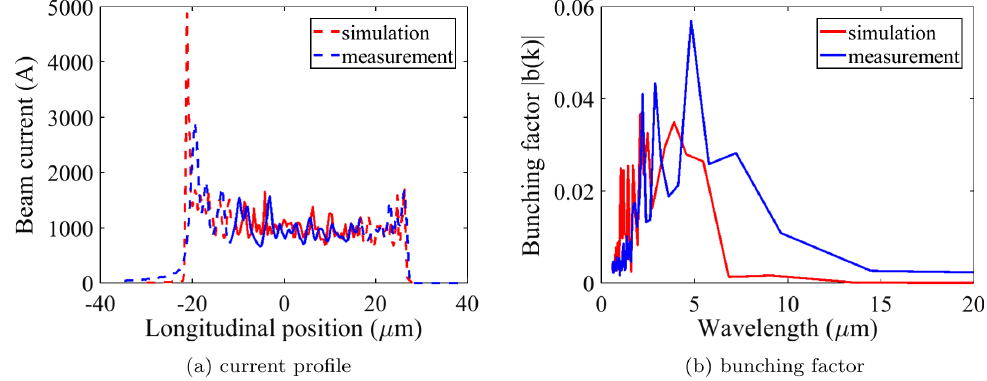
FIG. 6. The final current profile (left) and bunching factor (right) of the Fig. 5 longitudinal phase-space distribution with the laser heater off.